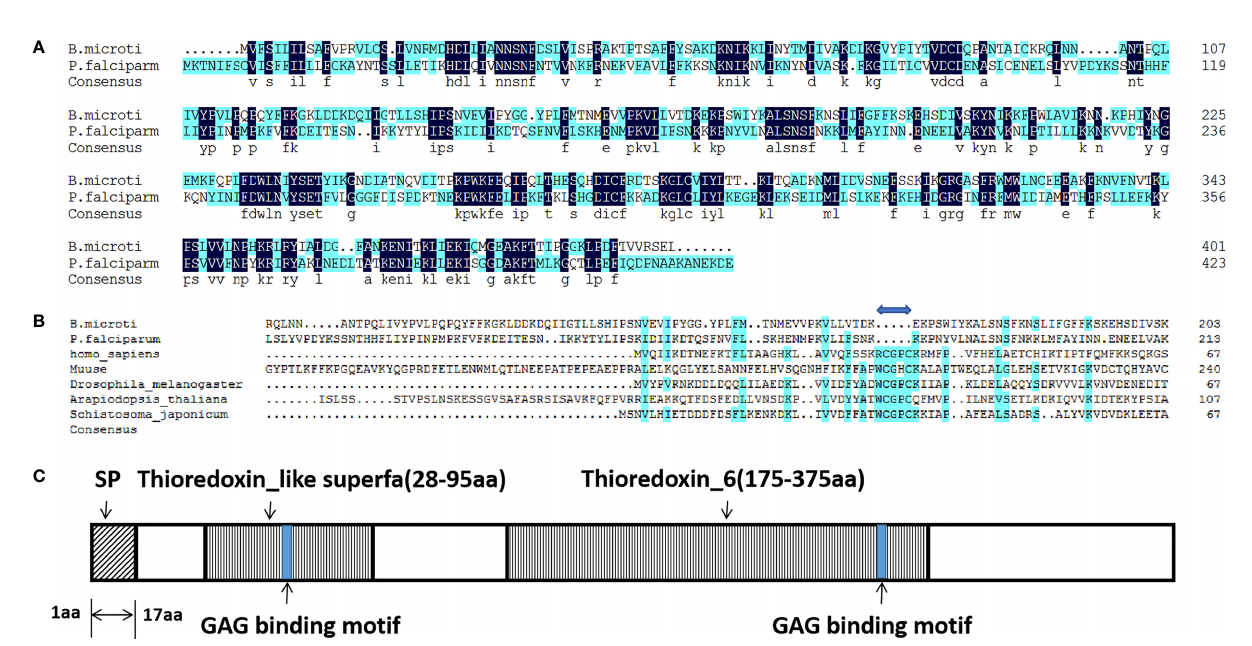
FIGURE 1 | Amino acid sequence alignments and schematic diagram of Bm Trx-like protein. (A) Amino acid sequence alignment of Trx-like proteins of B. microti and P. falciparum . (B) Amino acid sequence alignment of the Trx-like protein of B. microti with Trx proteins of other species. A gap (blue double-headed arrow) was observed in both Bm Trx-like protein and Pf Trx-like-mero protein sequences due to the deletion of the Cys-X-X-Cys (CXXC) active site. (C) Schematic diagram of the Bm Trx-like protein. This protein contained a signal peptide (SP; aa 1 – 17) at the N- terminus and two conserved Trx domains (Thioredoxin_like superfa, aa 28 – 95; Thioredoxin_6, aa 175 – 375). The blue boxes indicate the two glycosaminoglycan (GAG)-binding motifs.